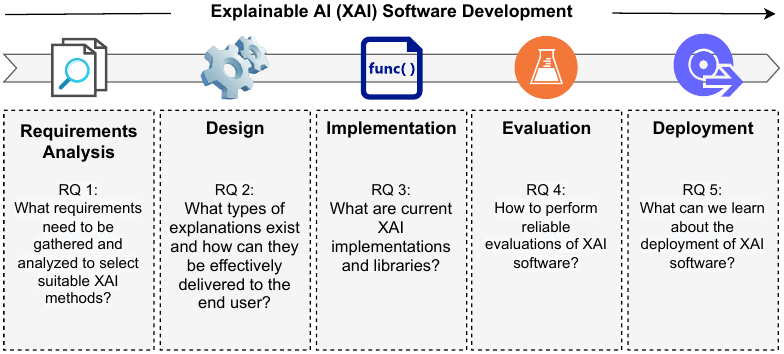
Figure 2. Addressed research questions (RQ) aligned to the XAI software development